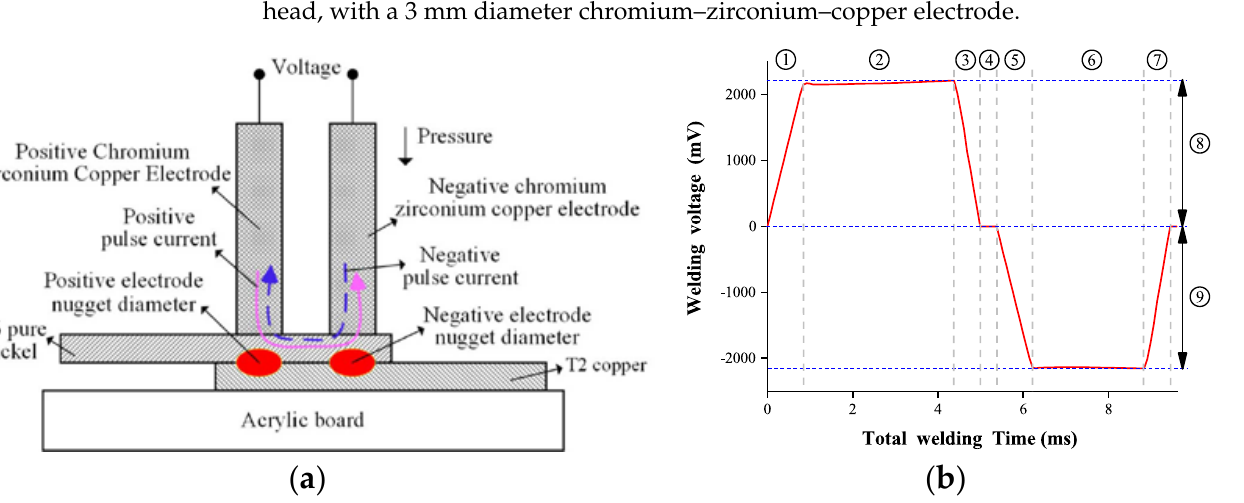
Figure 3. Geometry of the welded specimens.